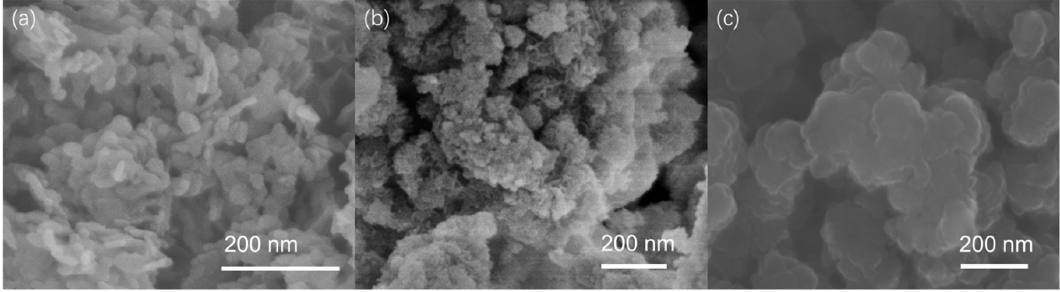
Figure 8. SEM images of AMO-Ni 3 Al 1 -CO 3 LDH ( a ), AMO-Ni 3 Al 1 -CO 3 LDO ( b ), and reduced AMO-Ni 3 Al 1 -CO 3 LDO ( c ) solids.